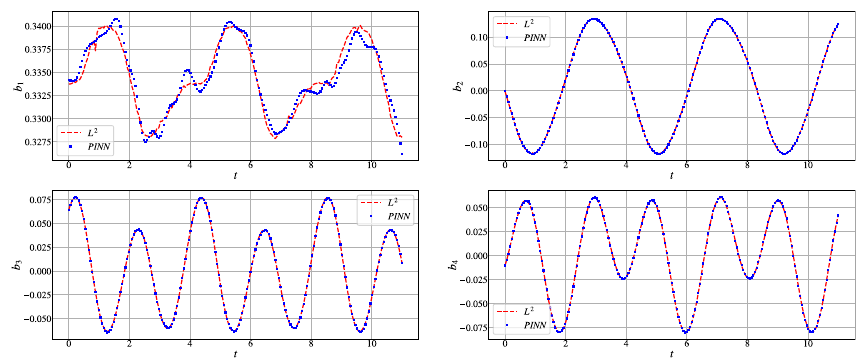
Fig. 7 The first four pressure reduced coefficients for the unknown input data